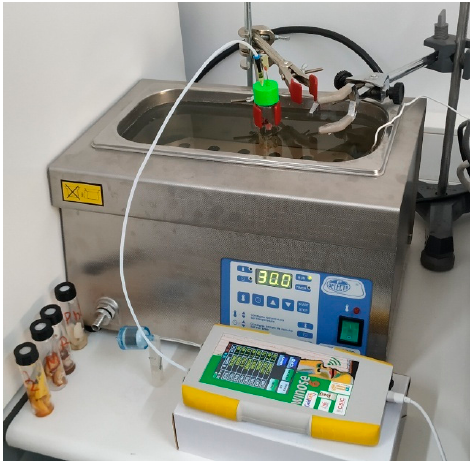
Figure 5. Test of mushrooms with the electronic nose WINOSE 6.